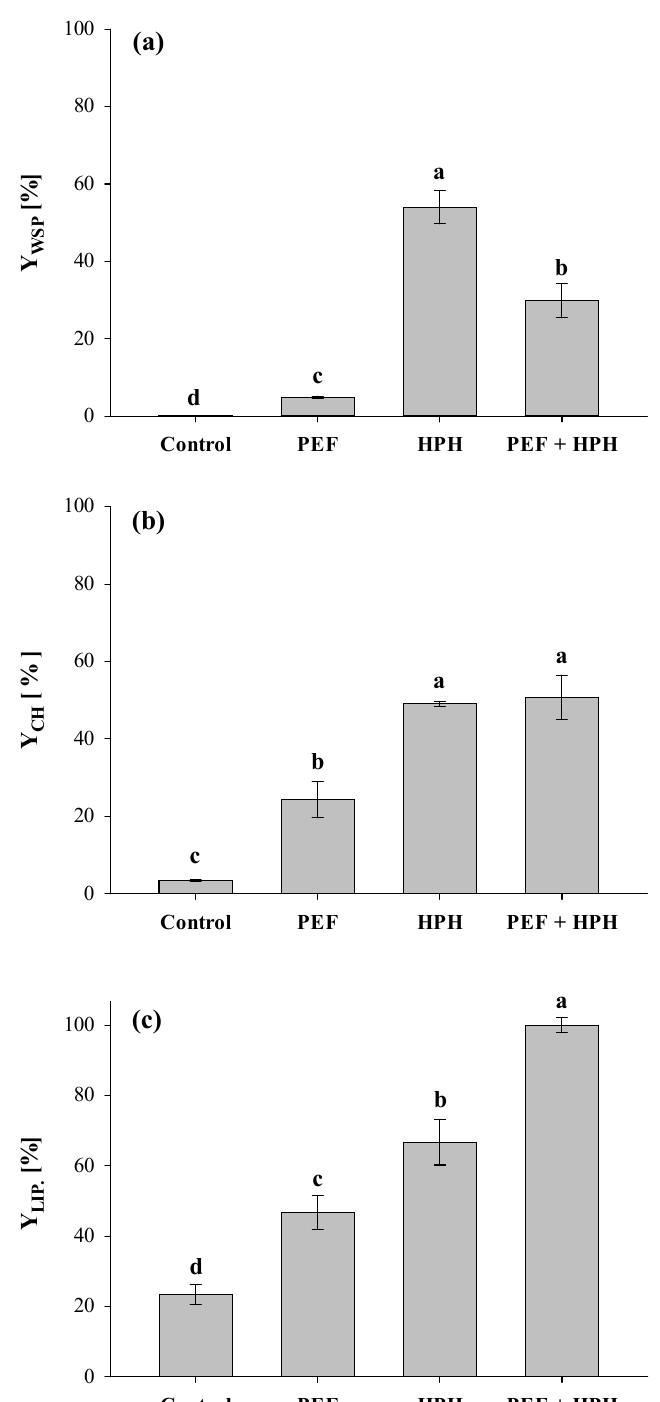
Figure 5. Yields of water-soluble proteins ( a ), carbohydrates ( b ), and lipids ( c ) extracted from C. vulgaris suspensions untreated, and treated by PEF alone, HPH alone, and combined PEF + HPH. Different letters above the bars indicate significant differences among the samples ( p ≤ 0.05).